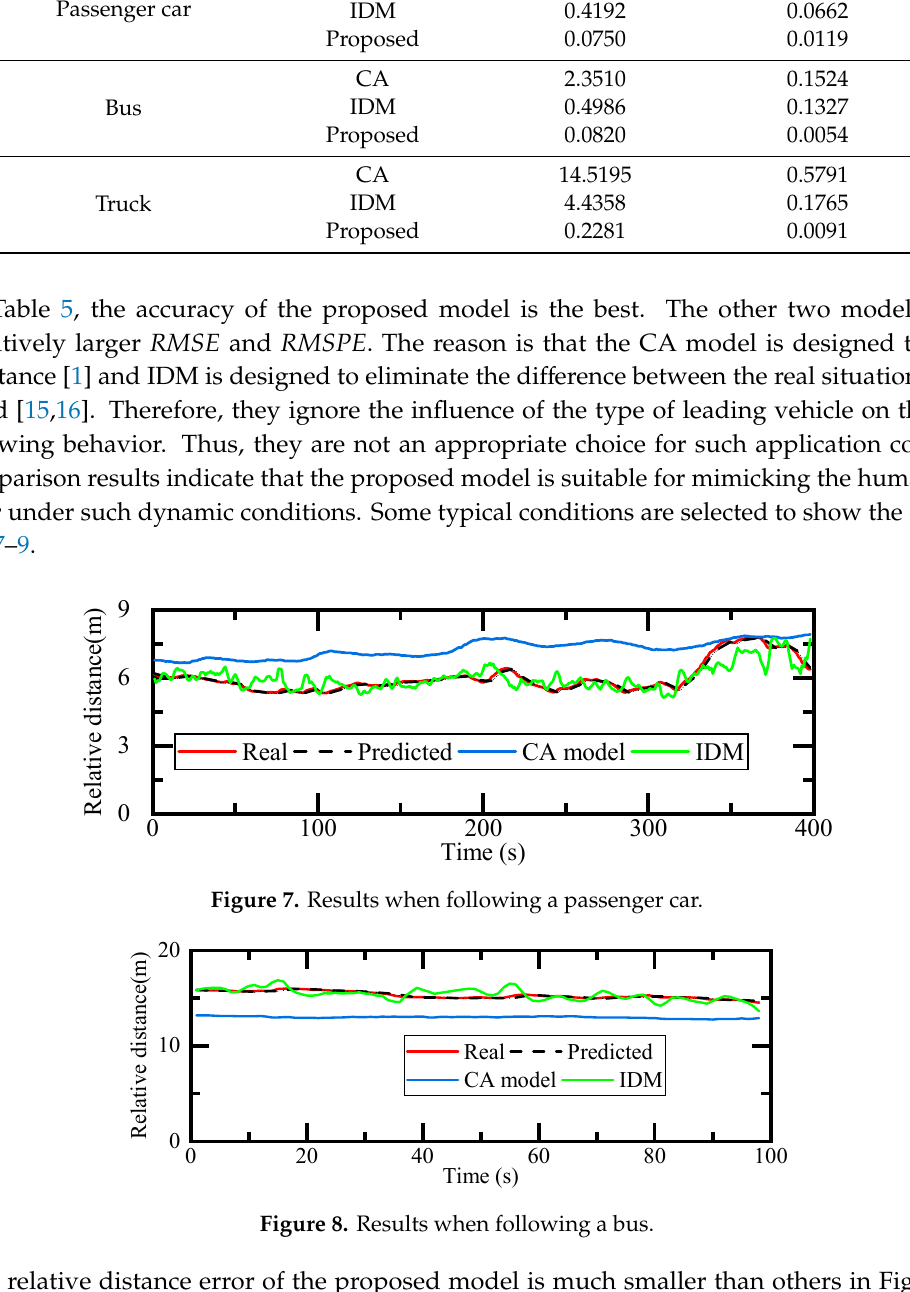
Figure 9. Results when following a truck. The relative distance error of the proposed model is much smaller than others in Figures 7–9. The output of IDM is closer to the real relative distance in Figure 7 and Figure 8. The CA model has the largest error of relative distance. In Figure 9, both CA and IDM output a smaller relative distance than the driver. The reason is that CA and IDM ignore the influence of leading vehicle type, which is mainly the outline of the leading vehicle [4]. A small-sized vehicle only blocks out a small portion of the traffic environment ahead. Comparatively, a larger vehicle easily causes critical accidents. Therefore, when following a passenger car, the human driver is more aggressive and keeps with the vehicle closer. On the contrary, if the leading vehicle is a bus or a truck, the proposed model keeps a larger relative distance with the preceding vehicle than CA and IDM (Figure 9). 7. Discussion and Future Work From the above-mentioned analysis, it is found that the proposed model can mimic human driver driving behavior, and the proposed model has a high level of accuracy of leading vehicle type identification. In this paper, we mainly focused on whether the different leading vehicle types have an influence on car-following behavior. However, individuals’ driving style were not considered. Potential directions in future work are discussed as follows. 7.1. Influence of Data Components Driving on the city road and highway road are different driving styles. In this work, the model does not divide naturalistic driving data into city road, highway, and others. In extraction data, raw data contains more than 75% city road data, about 20% highway data, and the rest of the data is country road or others. In this data, the vehicle also keeps a lower velocity and a shorter relative distance. Thus, the proposed model prefers to fit a city road or low velocity driving condition. For the reason given above, the data components need to be divided into suitable parts in future research work. 7.2. Influence of Individual Driving Style Car-following behavior is influenced by the driver’s personal characteristics. First, driving years of a driver can directly affect his or her driving habits. For example, a driver with more experience will demonstrate a more confident driving style. A driving condition which is easy for a seasoned